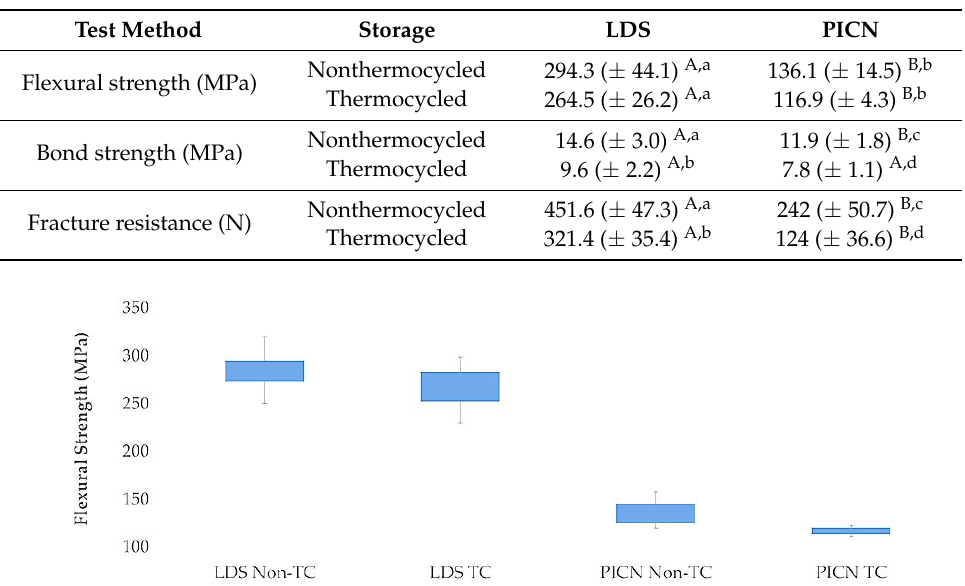
Figure 4. Box plot of microshear bond strength for each group. Figure 5. Box plot of fracture resistance for each group. Higher µSBS values were detected between the nonthermocycled LDS material and resin luting agent in comparison to the nonthermocycled PICN material ( p = 0.002). However, no significant difference was observed between the µSBS values of LDS and PICN specimens and resin luting agent when the specimens were subjected to thermocycling ( p = 0.06) (Table 2). The interactions between both parameters were not significant ( p = 0.423). The distribution of failure modes of the resin–ceramic specimens is presented in Figure 6. The predominant failure modes were adhesive failures for all groups, and frequencies of adhesive failures were higher in thermocycled groups. All groups showed mixed and cohesive failures except for the thermocycled PICN group in which cohesive failure was not observed. Representative failure types are shown in Figure 7.